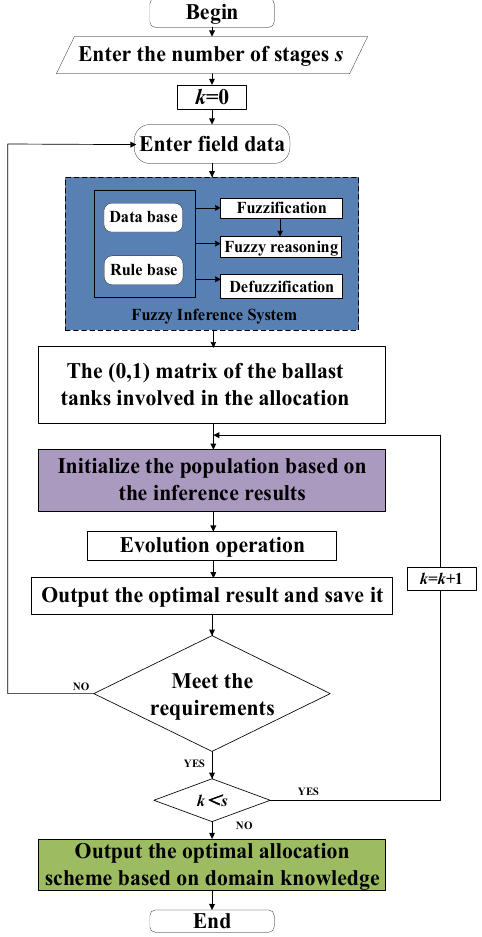
Figure 13. Flow chart of FPSO algorithm to solve ballast water dynamic allocation scheme.